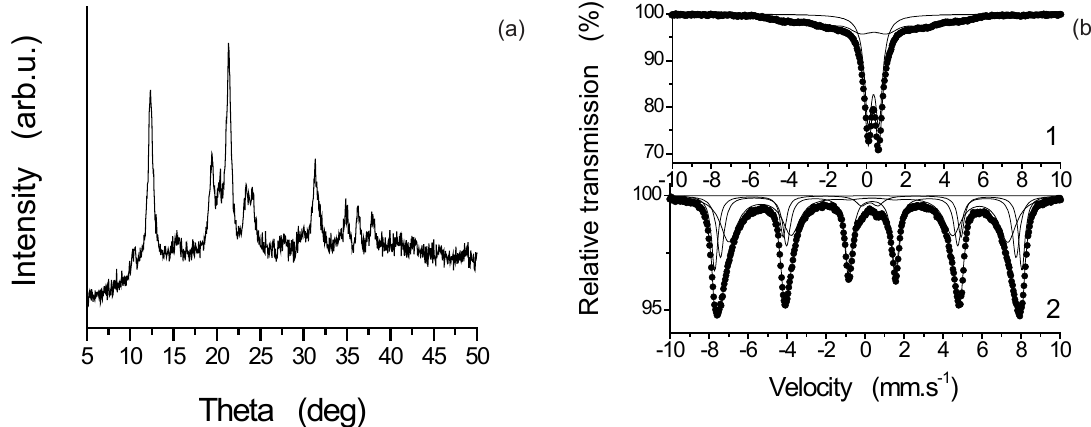
Figure 2. XRD (a) and Mossbauer spectra (b) of the natural biogenic material: (b1) - initial biomass and (b2) – the same sample after catalytic